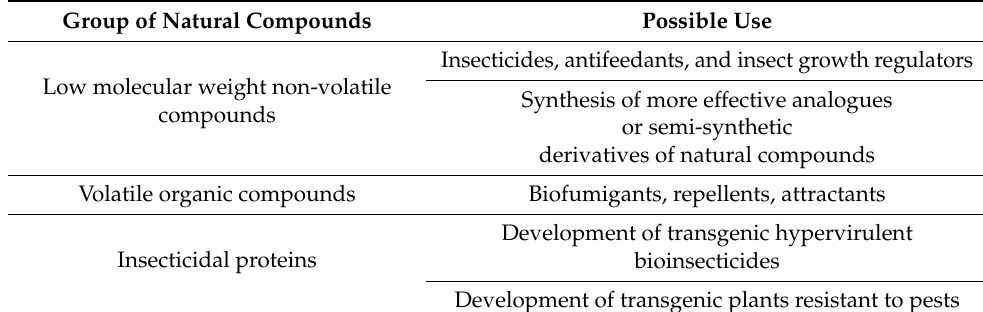
Table 1. Ways of using various natural compounds for control of pest arthropods.